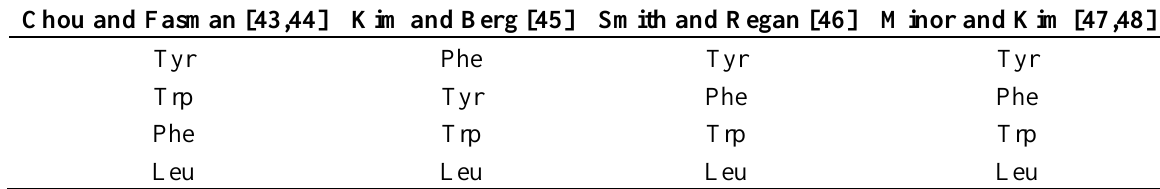
Table 8. β-sheet propensities of Tyr, Trp ,Phe and Leu ranked from high to low propensity. Chou and Fasman [43,44]